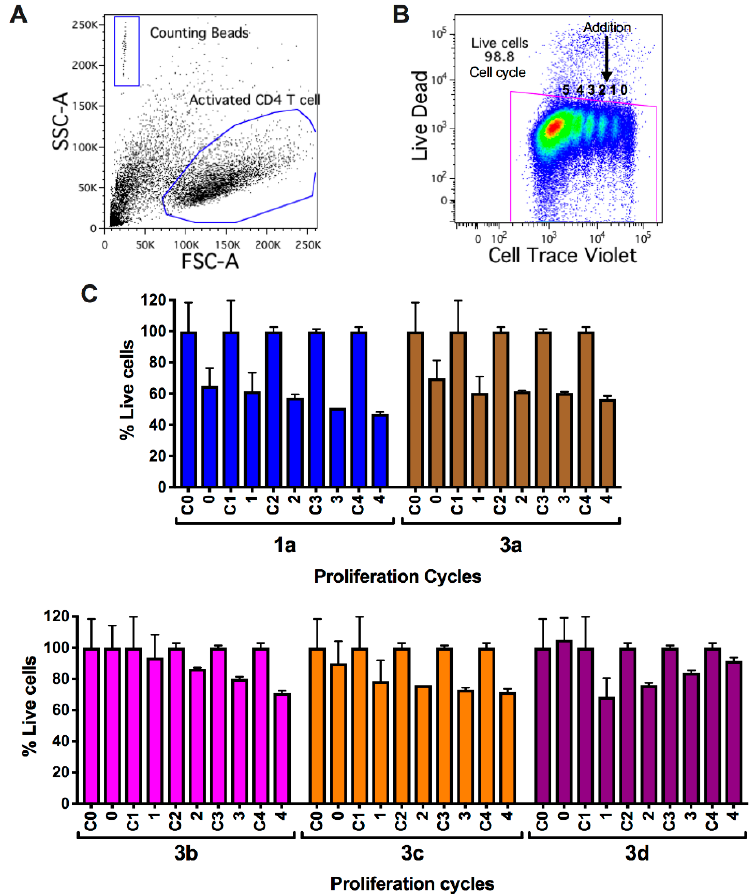
Figure 4. Viability and cell count analysis of Myrtenyl derivatives on CD4 + T lymphocytes in progressive proliferative cycles. ( A ) Representative dot plot of activated CD4 + T cells and counting beads after 6 days of culture. ( B ) Representative dot plot of cell cycles after activation of live CD4 + T cells (2 × 10 5 ) CellTrace Violet + with CD3 / CD28 Dynabeads and IL–2 (50 U / mL) in X–VIVO for 6 days. All compounds were added (EC 25 ) after 48 h post activation (Addition arrow) and incubated for four days. ( C ) Total number of live cells were counted with flow cytometry, using counting beads as a reference and a Live Dead dye. Viability is expressed as % compared to control, and data represent mean ± standard deviation of triplicated determinations in three independent experiments.